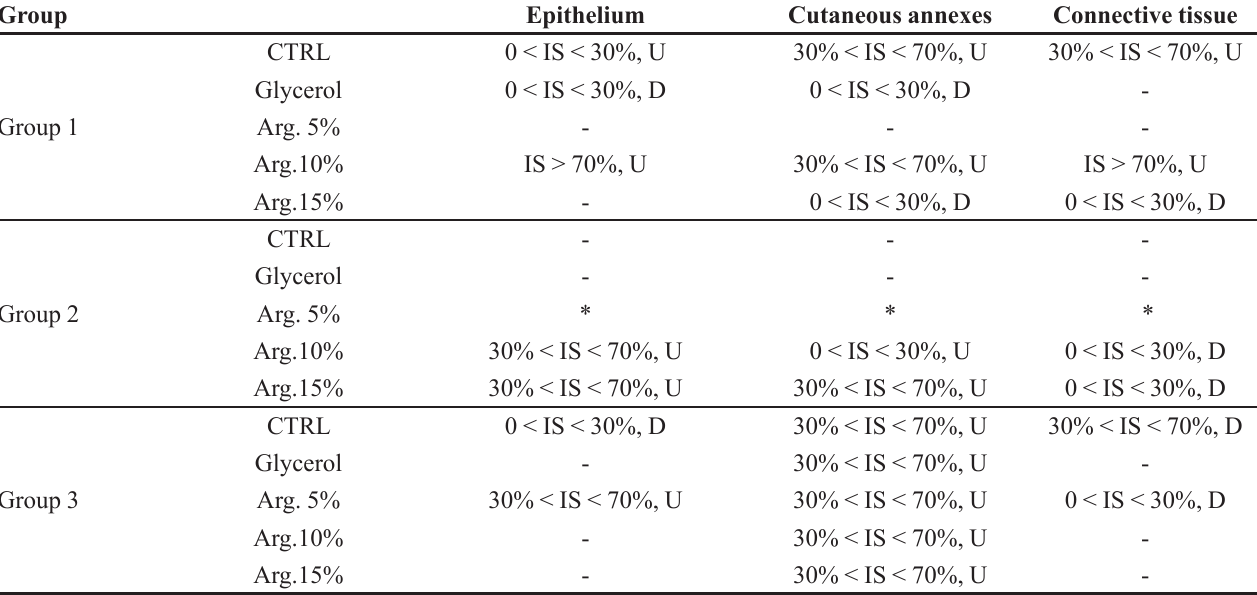
TABLE III - Immunohistochemical iNOS staining of female mouse skin Group Epithelium Cutaneous annexes Connective